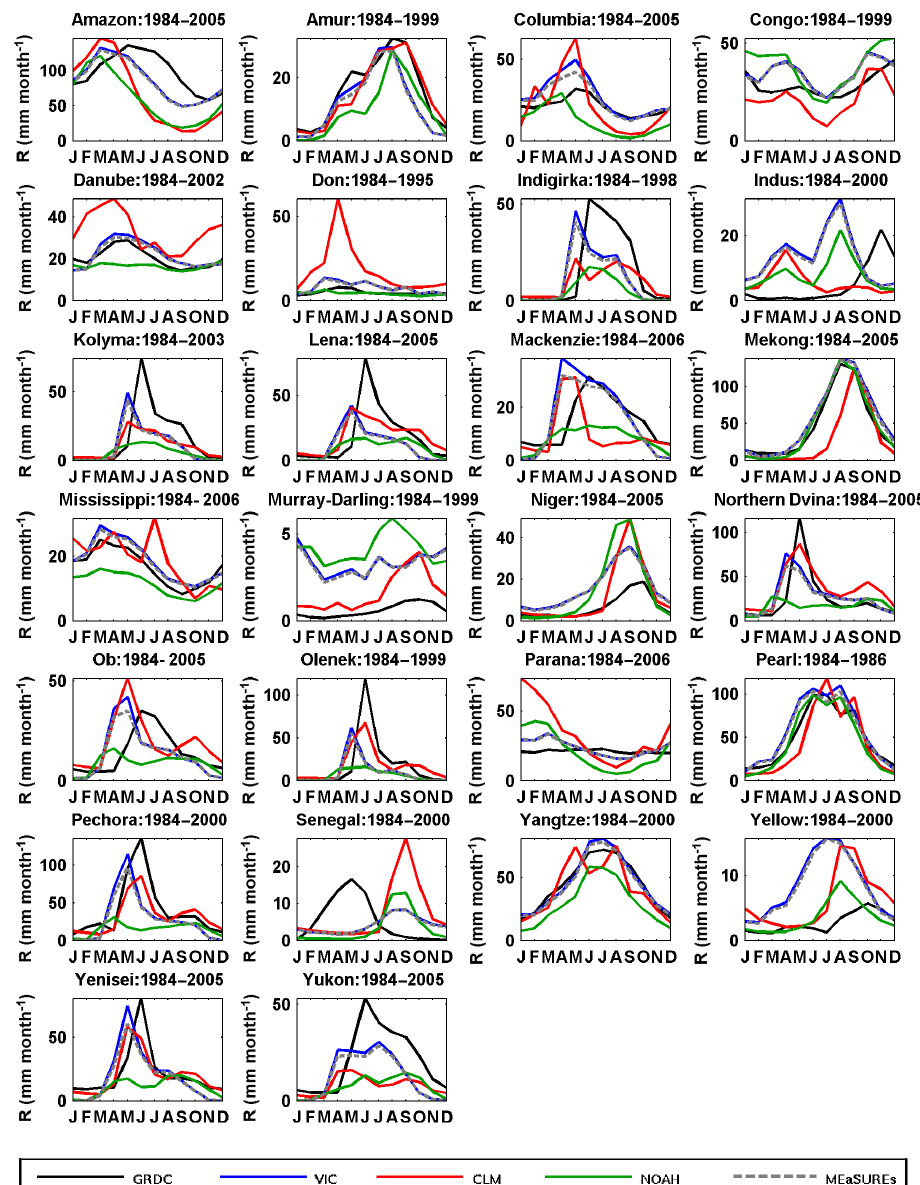
Figure 8. Seasonal cycles of runoff from VIC, CLM, NOAH, and MEaSUREs against GRDC runoff observations over 26 large basins for different periods according to in situ data